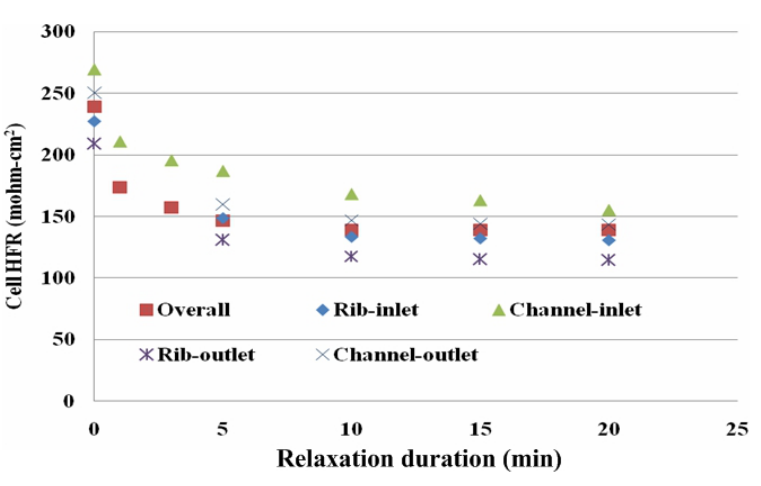
Figure 16. Local HFR relaxation following purging with gas at flow rate of 2